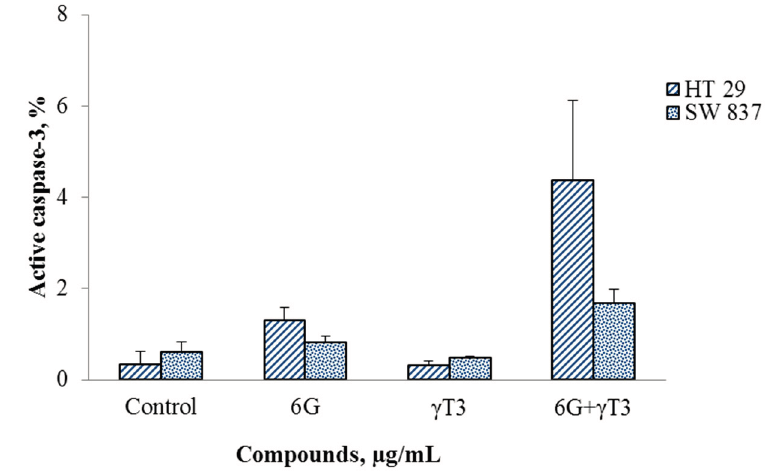
Figure 8. Combined of 6G+ γ -T3 treatment did not increase active caspase-3 in both HT-29 and SW837. There was also no significant difference of active caspase-3 determined in sub-lethal concentrations of individual 6G and γ -T3 treatments. Data are presented as mean ± SEM of three independent